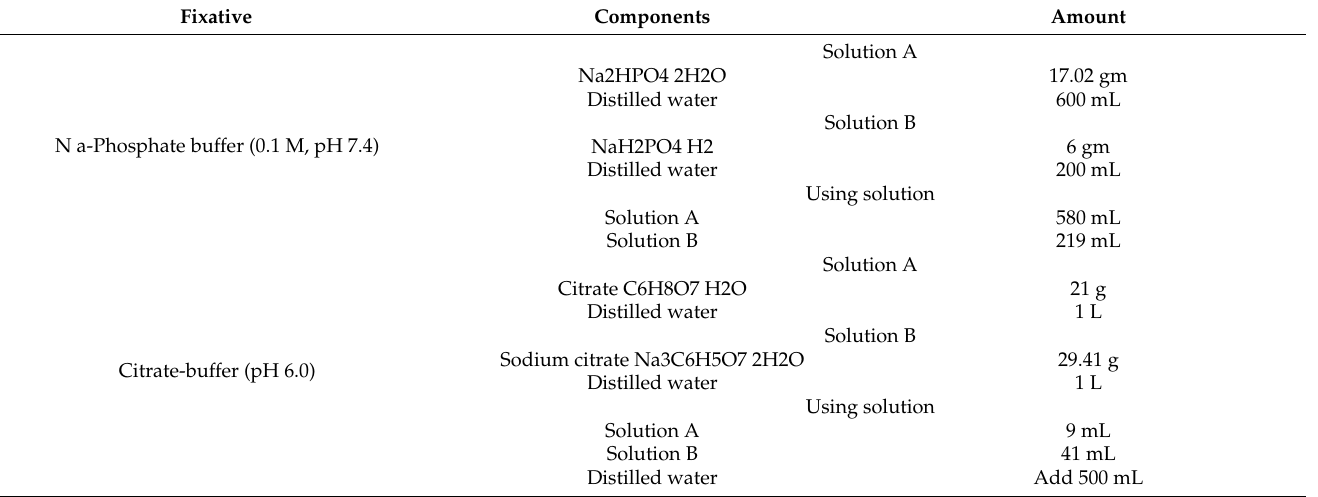
Table 2. Components of the fixatives.